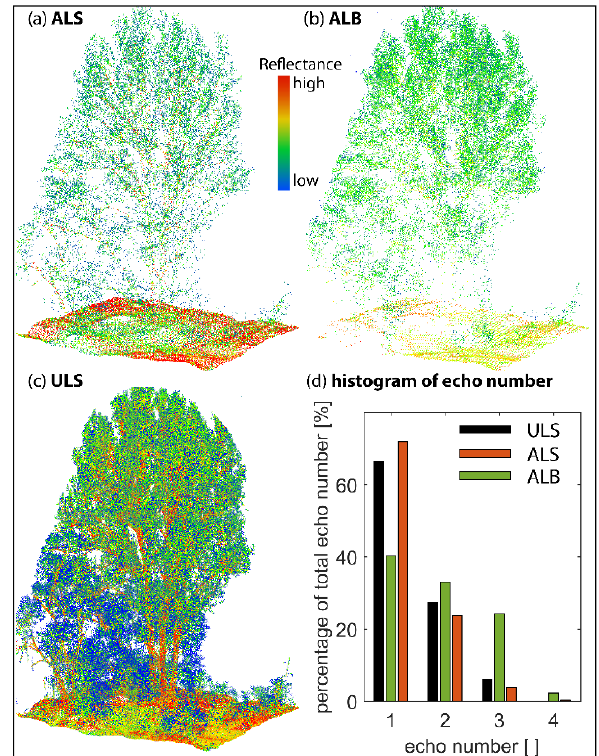
Figure 3. (a-c) 3d point cloud of one tree color-coded with reflectance; (d) Histogram of echo numbers for all selected trees and laser systems (cf. section